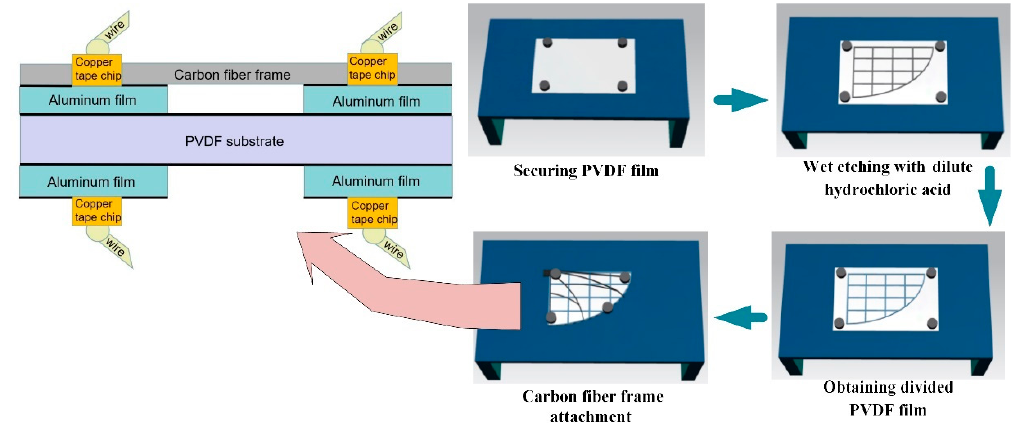
Figure 3. The PVDF wing cross-section sandwich structure and process of wet etching.